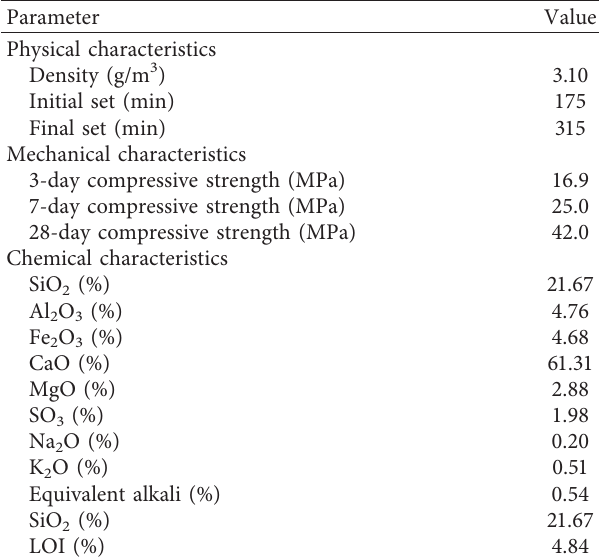
Table 1: Characteristics of Portland